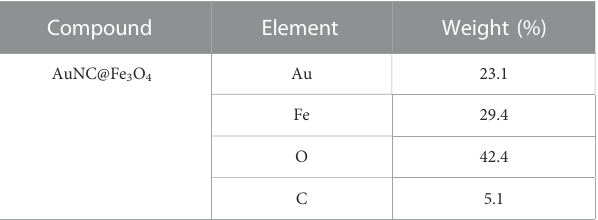
TABLE 1 The statistics of elements analysis for AuNC@Fe 3 O 4 by energy- dispersive X-ray (EDX). Compound